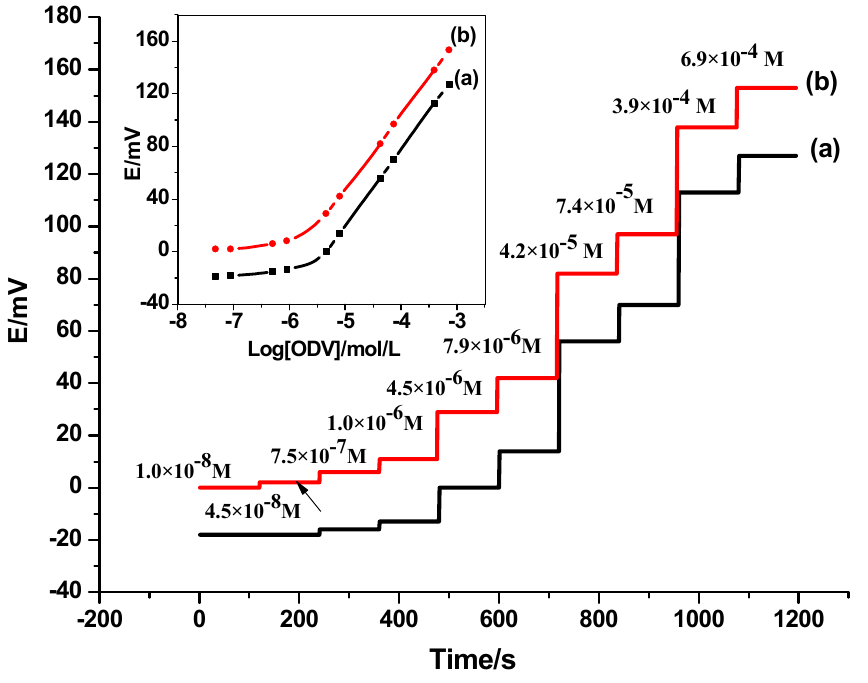
Figure 2. Time response of ( a ) the non-modified (C/MIP-ODV) and ( b ) the modified (C/SWCNTs/MIP-ODV) in phosphate buffer (10 mmol/L) pH = 6.0. (Inset: calibration